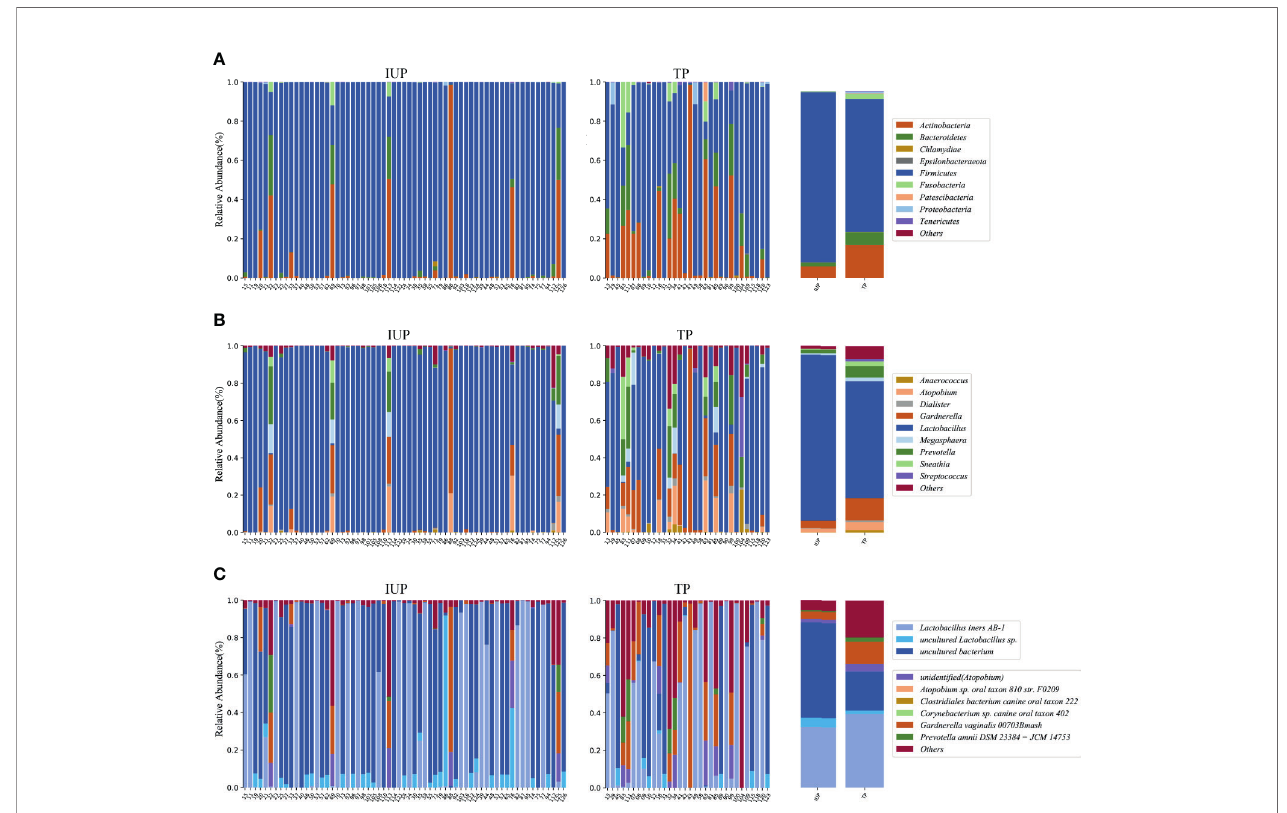
FIGURE 3 | Vaginal microbial composition in subjects with intrauterine pregnancy and with tubal pregnancy. (A) Phylum level; (B) Genus level; (C) Species level composition in subjects with intrauterine pregnancy and with tubal pregnancy. Bar charts showing the vaginal microbial taxa composition in mean values (on the right side) and individual subjects with intrauterine pregnancy and with tubal pregnancy (on the left